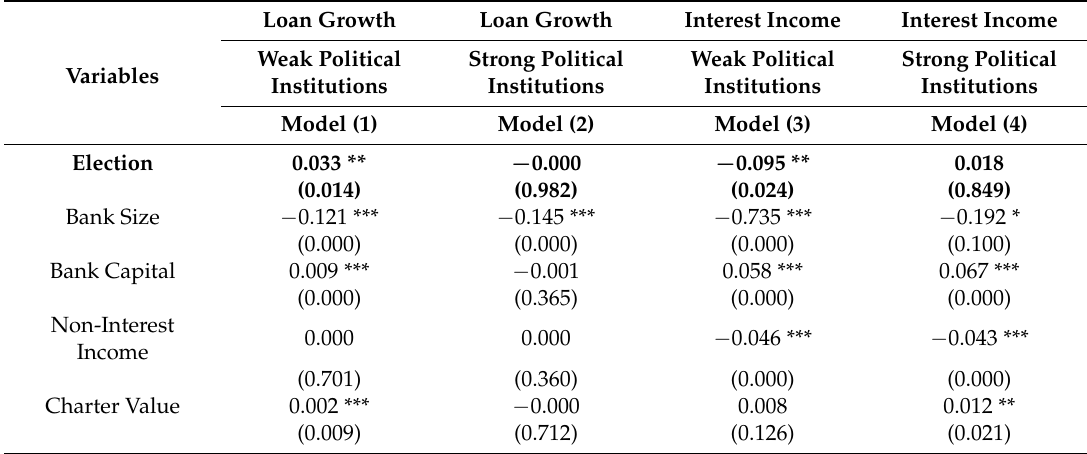
Table 5. Political institutions and political pressure on state-owned